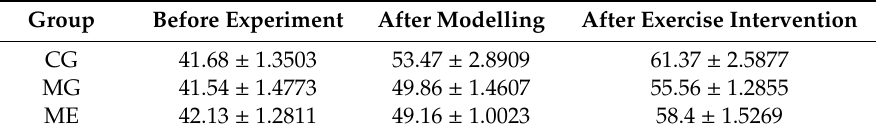
Table 2. Weight of